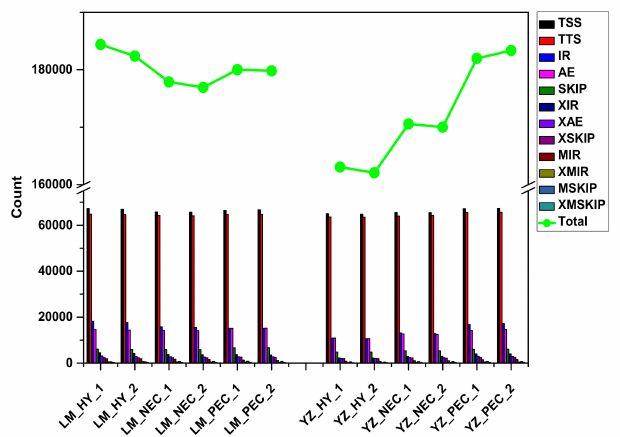
Figure 5. Alternative splicing events in di ff erent developmental stages during cotton SE in the two genotypes. TSS, transcript start site. TTS, transcript end site. IR, intron retention. AE, alternative exon end. SKIP, skipped exon. XIR, IR-like. XAE, AE-like. XSKIP, SKIP-like. MIR, Multi-IR. XMIR, MIR-like. MSKIP, Multi-exon SKIP. XMSKIP,